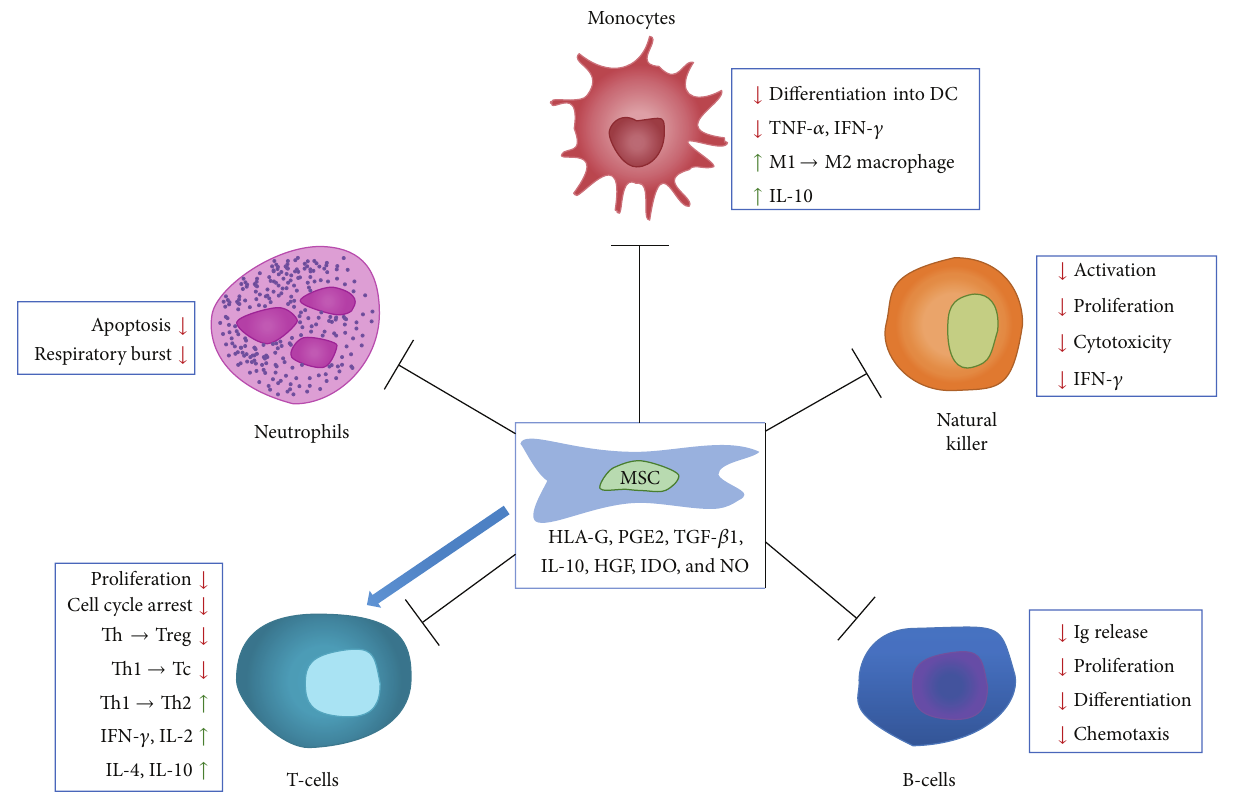
Figure 3: MSCs exert various effects on immune cells. A summary of MSC-mediated effects on the immune response. Various factors secreted by MSC exert an inhibitory effect on cells of the immune system which are involved in the fibrotic process (HGF: hepatocyte growth factor, HLA: human leukocyte antigen, IDO: indoleamine 2,3-dioxygenase, IFN- 𝛾 : interferon- 𝛾 , Ig: immunoglobulin, IL: interleukin, MSC: mesenchymal stromal cell, NO: nitric oxide, PGE2: prostaglandin E2, Tc: cytotoxic T-cell, TGF- 𝛽 : transforming growth factor- 𝛽 , TNF- 𝛼 : tumor necrosis factor- 𝛼 , Th: helper T-cell, and Treg: regulatory